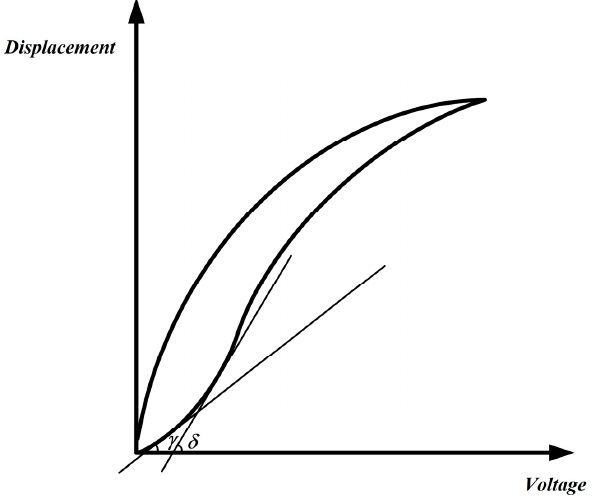
Figure 11. Schematic diagram of the tangent to the voltage-displacement hysteresis curve. The voltage-displacement data can approximate the characteristic curve and, thus, establish the voltage-displacement co-ordinate system. If m is the m th data obtained from the experiment, the hysteresis loop passes through the point ( v m , d m ) . Define the equation of the tangent line y tan ( v ) of the hysteresis rate at as